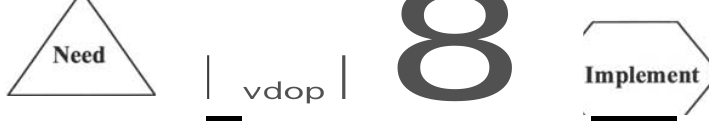
Figure 4: The Historic Procurement Process